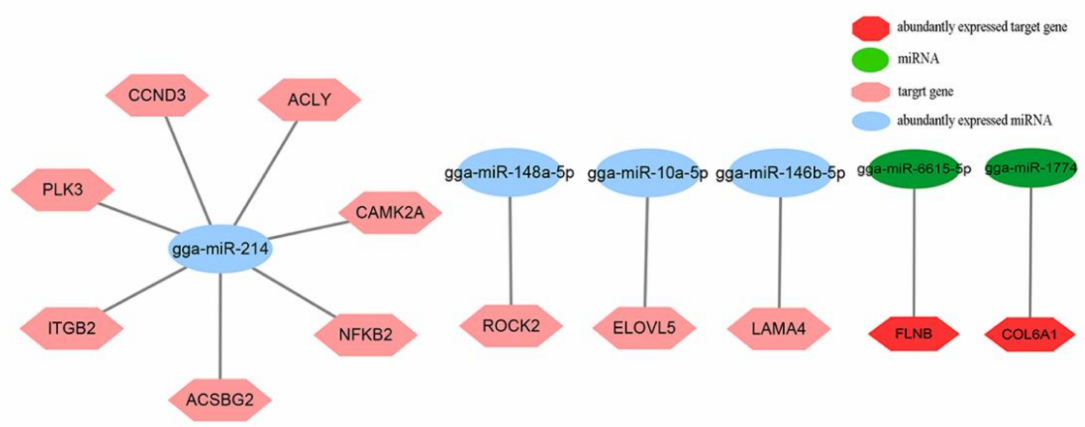
Figure 6. Integrated analysis of the abundantly expressed miRNAs–mRNAs networks and abundantly expressed miRNAs–abundantly